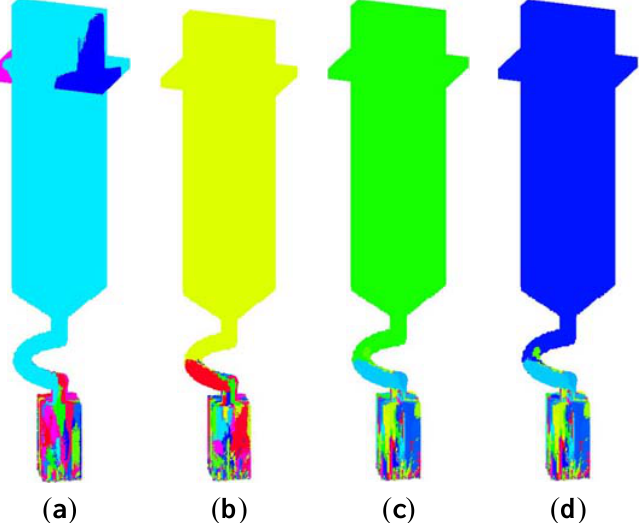
Figure 7. Simulated Microstructures of the four groups ( a ) SG1; ( b ) SG2; ( c ) SG3; ( d ) SG4.